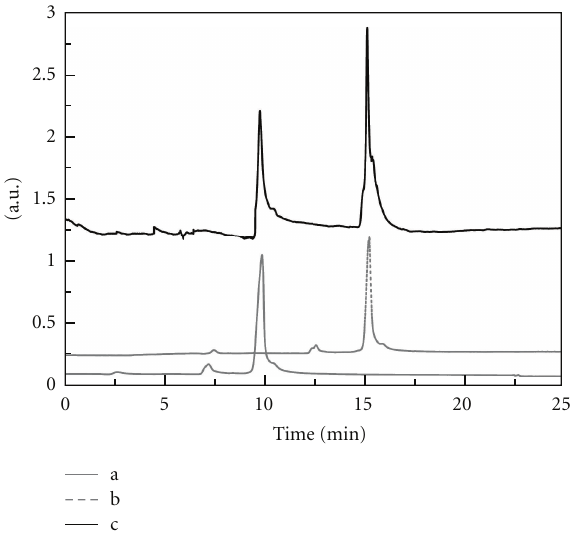
Figure 1: The electropherograms of standard substance and rehy- dration of bovine colostrum powder after cloud point extraction. There are alphalactalbumin (a), betalactoglobulin (b), and the sample (c).